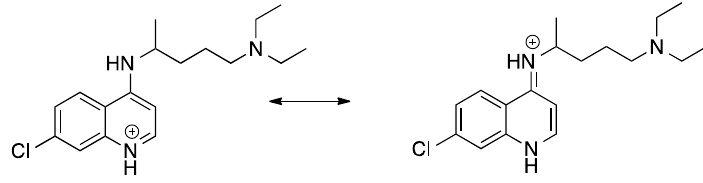
Figure 1. Resonance stabilization of the positive charge on the protonated ring nitrogen of chloroquine [55].